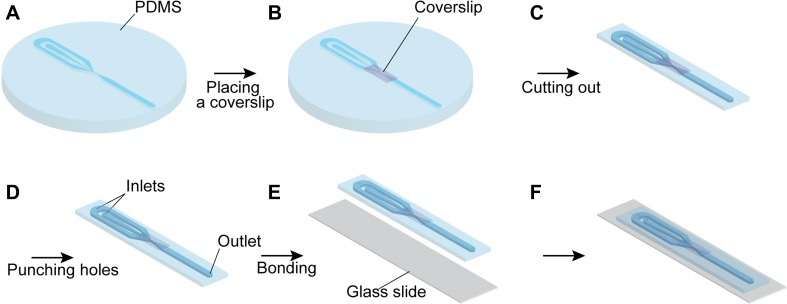
Fabrication of the Microfluidic Chip.(A) PDMS is filled on the mold of the microfluidic channel. (B) The small piece of the coverslip is placed above the observation area on the PDMS. (C) The PDMS is cut out into a proper size. (D) The inlets and outlet holes are opened. (E) The PDMS and glass slide are bonded using a plasma cleaner. (F) The microfluidic chip is completed and ready for use.